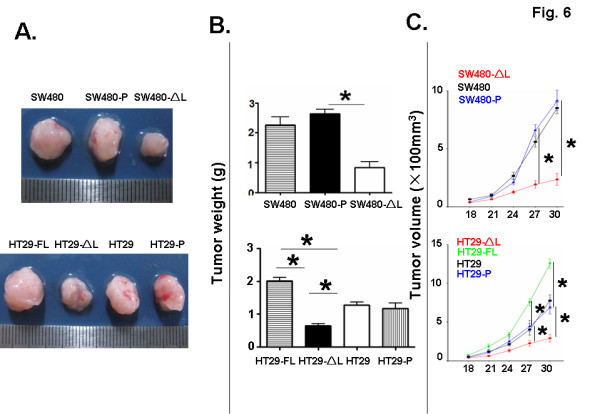
Tumor formation in vivo. (A) Different SW480 and HT29 cell lines were injected subcutaneously into nude mice. Tumors were dissected 30 days after the inoculation and were photographed; representative tumors are shown. (B) Tumor weights were compared on day 30 after the tumor inoculation. (C) Tumor volume. Tumor volume was monitored every 3 days from day 18 after the inoculation by measuring tumor length (L) and width (W) with a sliding caliper. Tumor volume = L × W2 × 0.51. Bars, mean ± SD. *P < 0.05, n > 3.